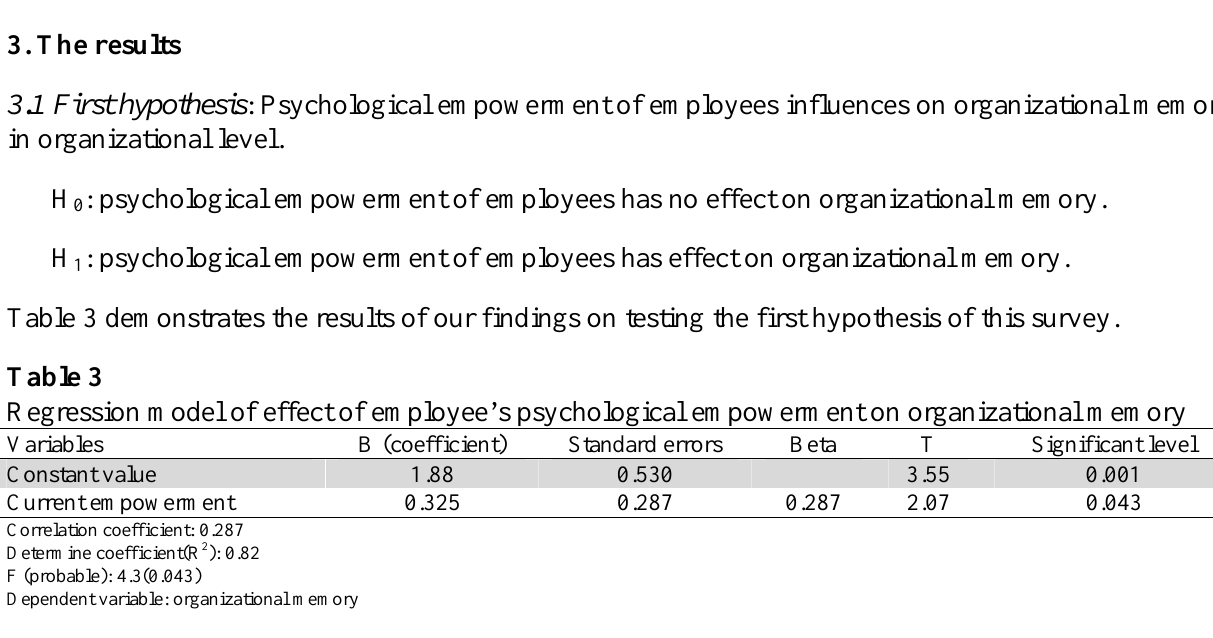
Psychological empowerment